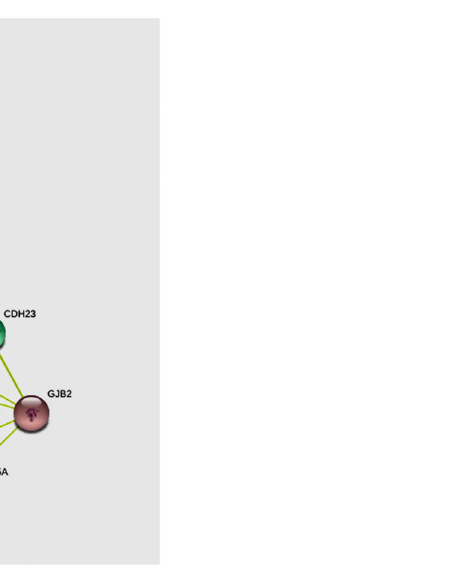
Figure 5. The interactive protein network for human TMPRSS3 predicted by STRING 9.1. Proteins predicted to interact with human TMPRSS3 include multiple known deafness proteins such as MYO7A, GJB2, DFNB59 and SLC26A4. The software tool is available in the website: